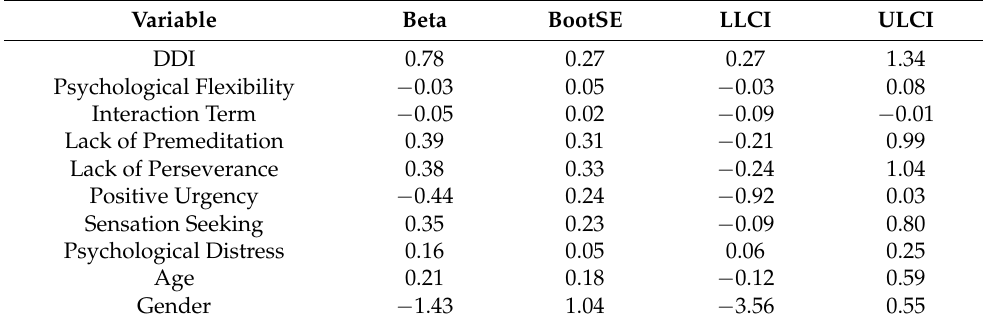
Table 2. Results of bootstrapped moderation